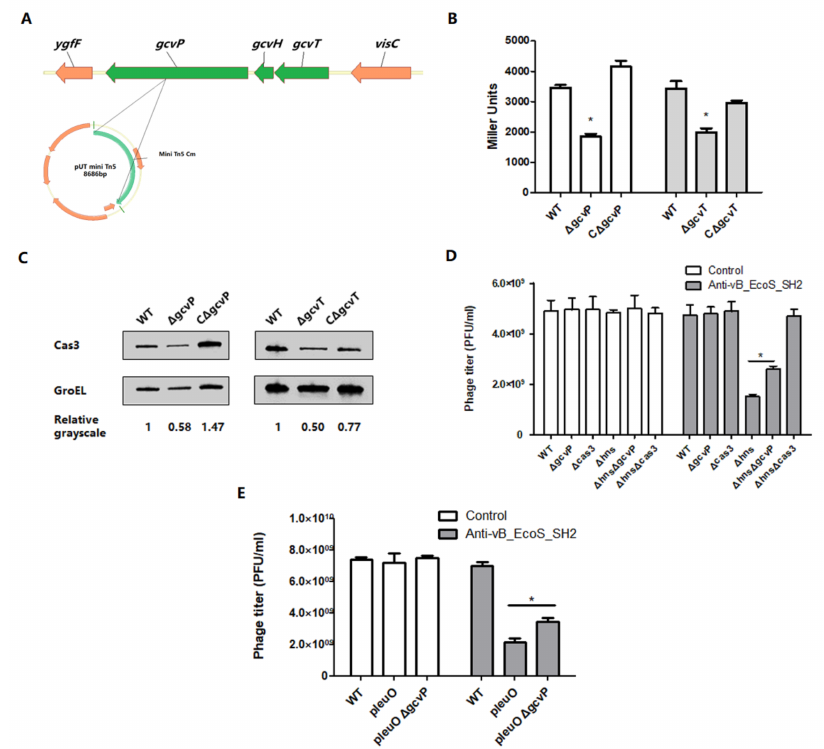
Figure 2. Mutation of gcvP or gcvT decreases cas3 expression to a ff ect phage infection. ( A ) The transposon insertion site. ( B ) The β -gal activity of the cas3 promoter was measured by reporter plasmids in wild type (WT) (EC11), ∆ gcvP (EC21), C ∆ gcvP (EC31), ∆ gcvT (EC41), or C ∆ gcvT